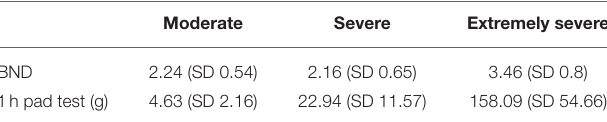
TABLE 5 | BND and the severity of